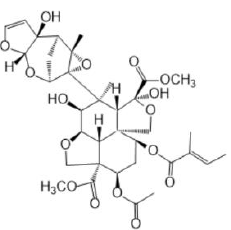
Figure 3. The structure of neem compound.